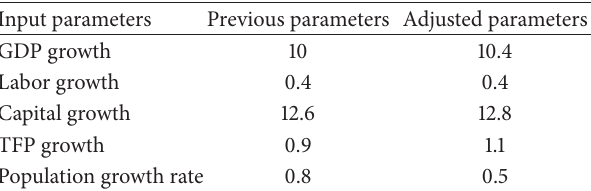
Table 2: The adjustment of GCAM input parameters in 2010 (unit: